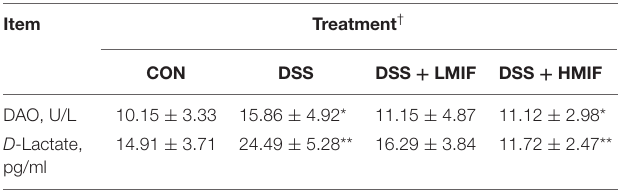
TABLE 2 | Effects of Morchella importuna flavones on the serum DAO activity and D-lactate concentration in DSS-challenged mice.